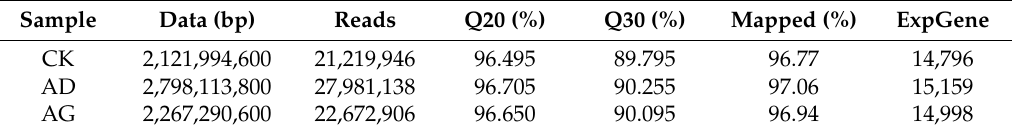
Table 1. Quality of sequencing data for the AD, AG, and CK samples. Note: AD, 56.33 mg/mL of α - pinene. AG, 214.5 mg/mL of α -pinene. CK, control. ExpGene, Expression genes.